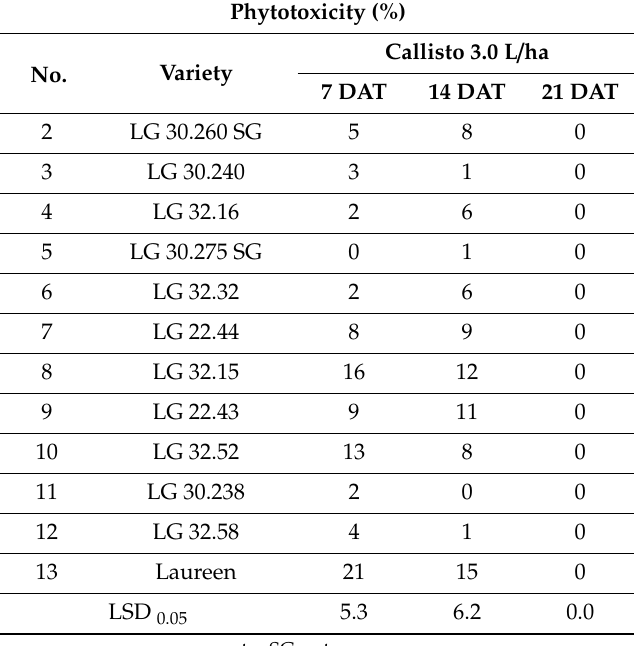
Table 3. Sensitivity of maize varieties to the herbicide Callisto 100 SC (mesotrione) varieties bred by Limagrain Central Europe.